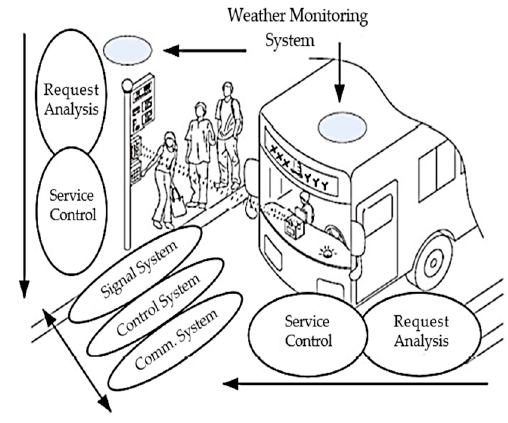
Figure 1. Intelligent bus system model for weather monitoring (reproduced from [9]).